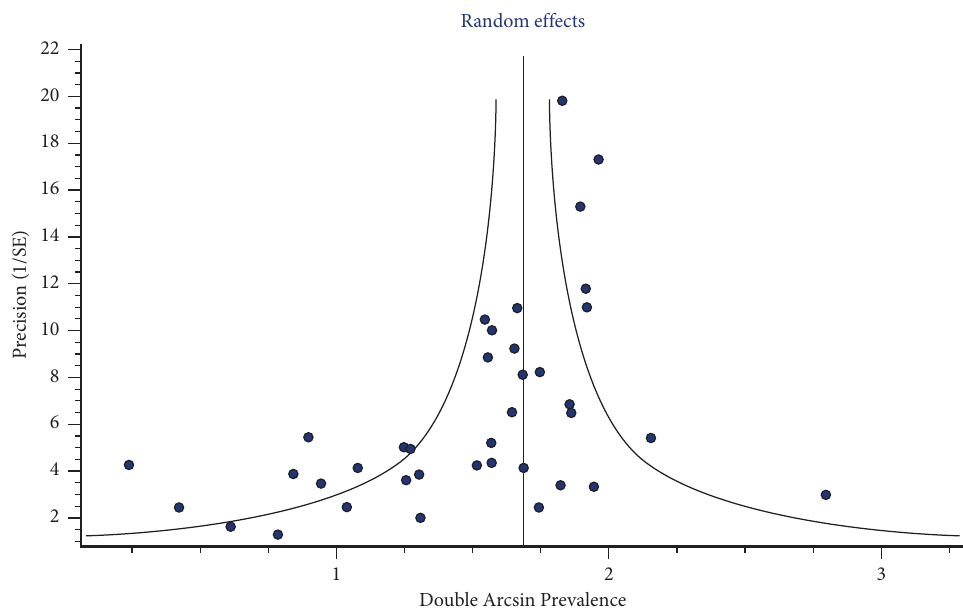
Figure 10: Funnel plot of global patient-level prevalence of bilateral symmetrical distribution of three-rooted